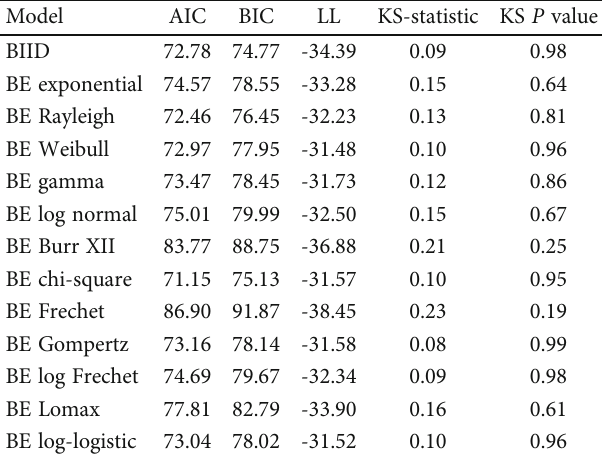
Table 13: Comparison of BIID with class of BEGDs using real dataset-1.